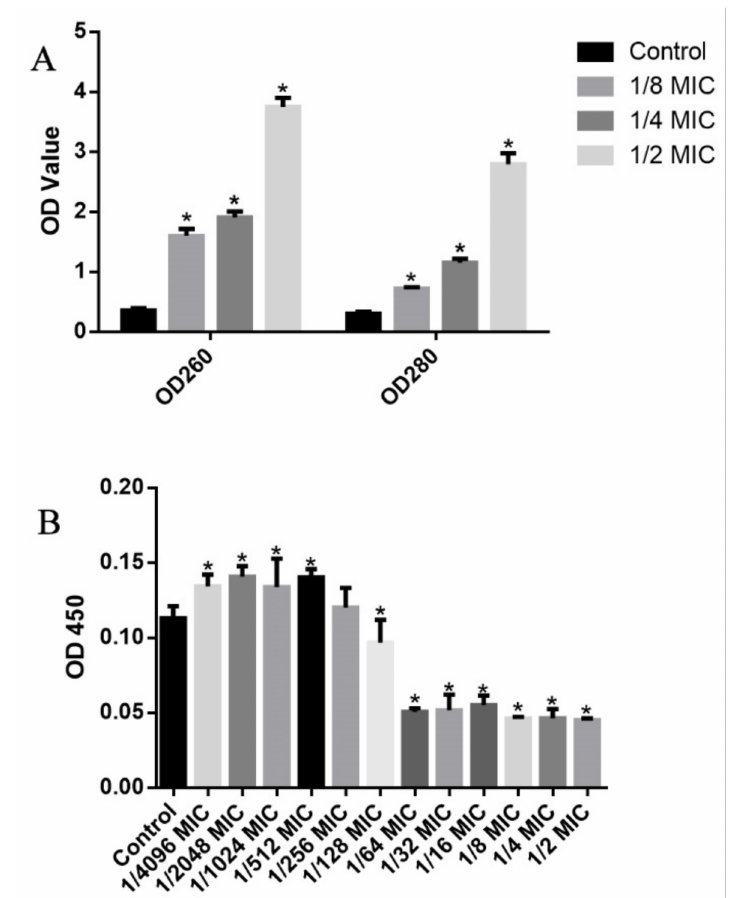
Figure 10. Effects of different concentrations of LCEO on intracellular DNA and protein leakages ( A ) and biofilm biosynthesis ( B ) of A. baumannii 17. OD 260 , OD 280 and OD 450 value represent the levels of intracellular DNA leakages, intracellular protein leakages and biofilm biosynthesis in different groups, respectively. Note: The data represent the means ± standard deviation of the results. The “*” on the top of a data column indicates a significant difference between this group and the control group ( p <